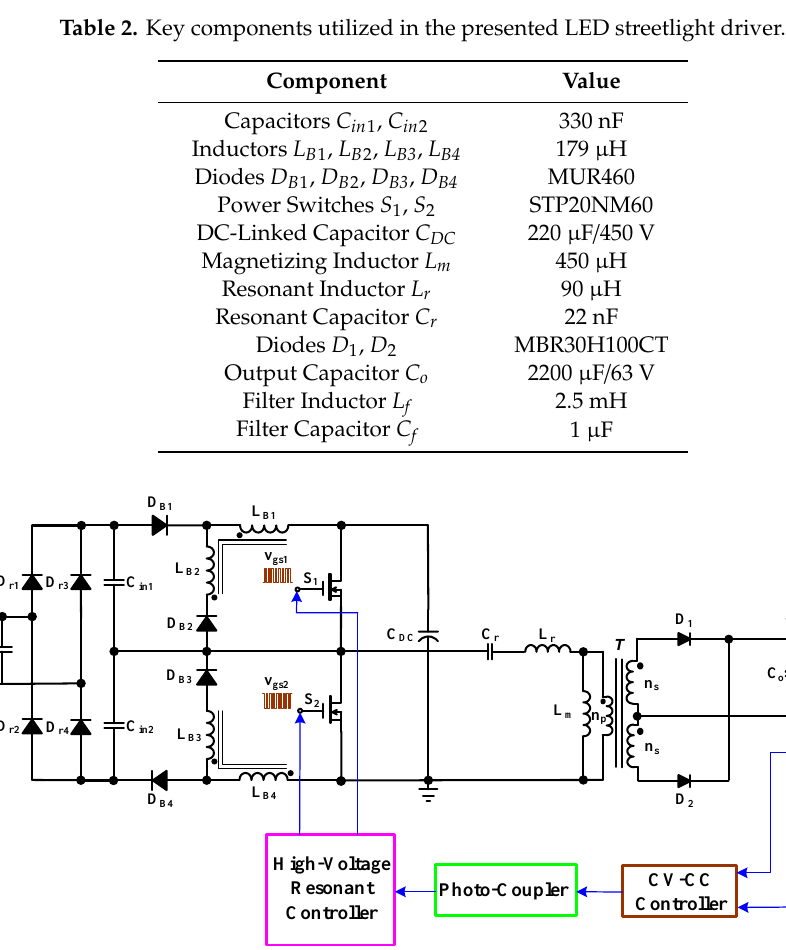
Figure 7. The proposed LED streetlight driver with control block diagram.